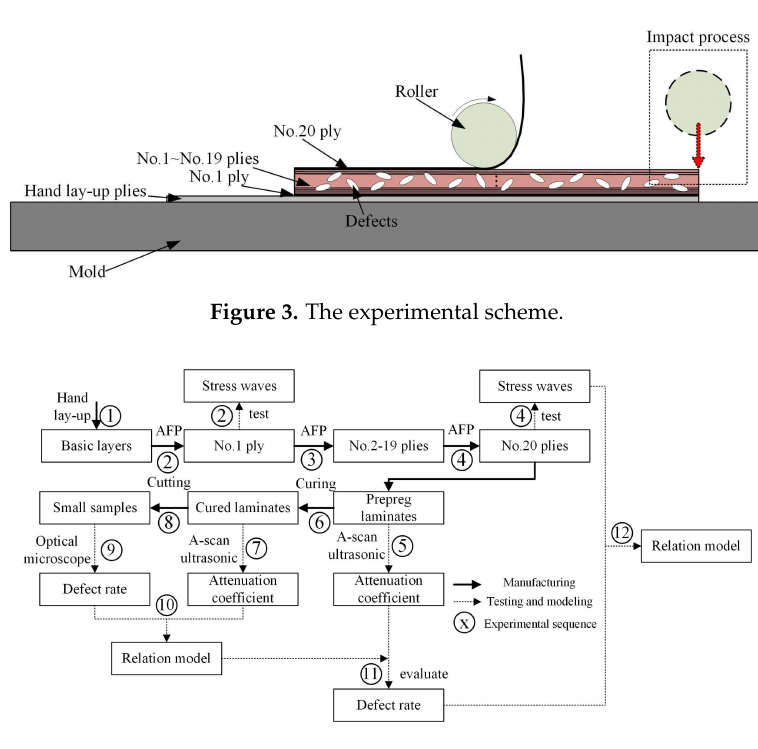
Figure 4. Experimental process and